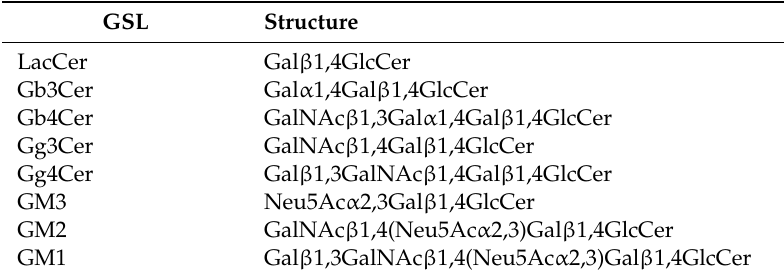
Table 3. Structures of glycosphingolipids (GSLs) used in this